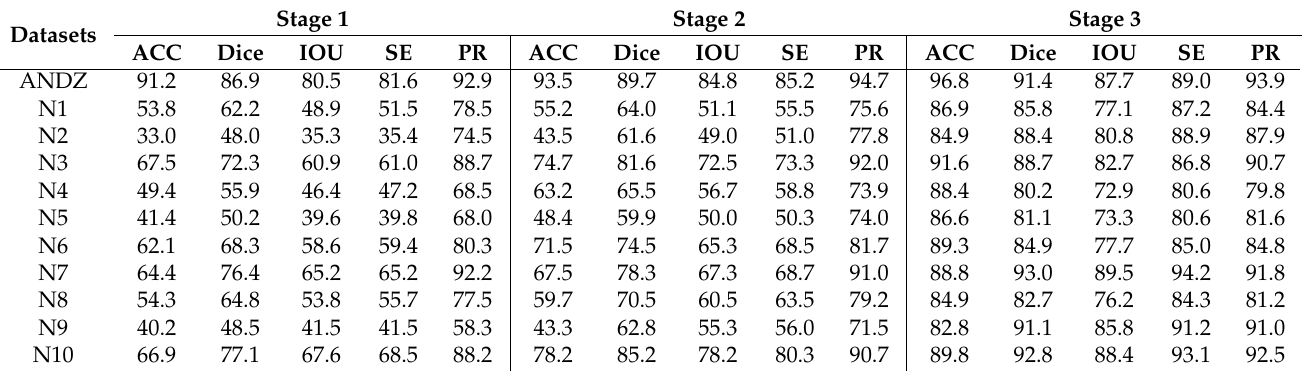
Table 3. Comparison results on each stage in terms of ACC, Dice, IOU, SE, and PR. Each stage corresponds to each step in Algorithm